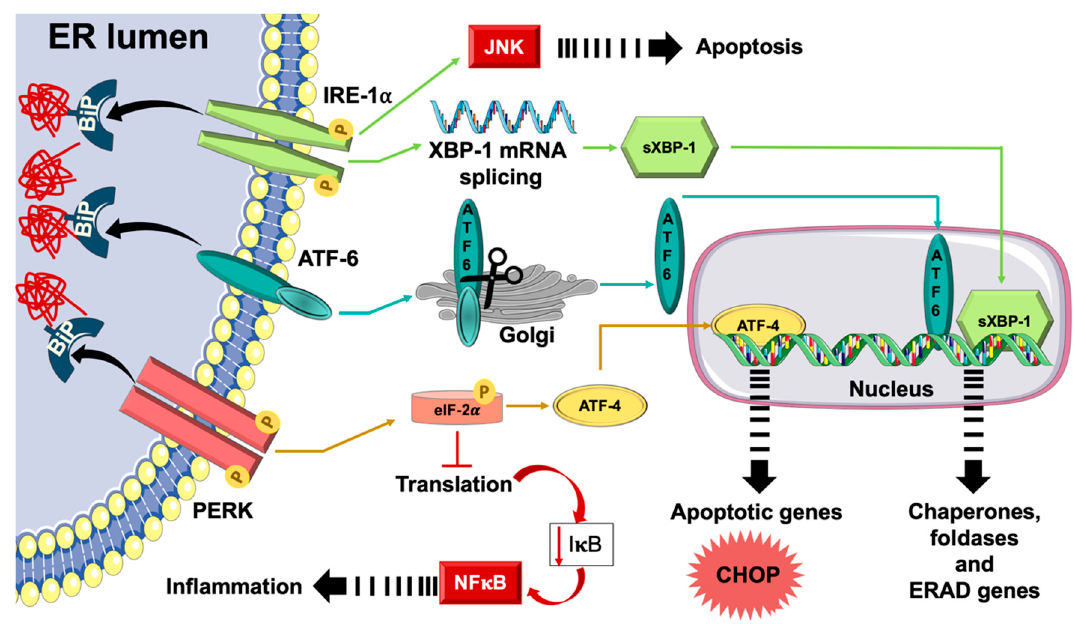
Figure 1. Unfolded protein response (UPR). Upon the buildup of misfolded and/or unfolded proteins inside the endoplasmic reticulum (ER), the chaperone, binding immunoglobulin protein (BiP), dissociates from and, thus, activating the three ER transmembrane proteins, protein kinase-like endoplasmic reticulum kinase (PERK), activating transcription factor (ATF)-6, and inositol requiring enzyme (IRE)-1 α . Activated PERK phosphorylates eukaryotic initiation factor (eIF)-2 α blunting, thus, general translation of proteins with the selective synthesis of transcription factor, ATF-4, being allowed. Free ATF-6 transfers to the Golgi apparatus where it gets cleaved and, hence, activated. Activated cleaved ATF-6 relocates to the nucleus and boosts the transcription of molecular chaperones that can help in improving ER protein folding functions. Activated IRE-1 α causes the mRNA splicing of X-box binding protein (XBP)-1 and generates an active splice variant (sXBP-1) which stimulates the transcription of genes controlling the expression of several molecular chaperones, foldases, and proteins the ER-associated degradation (ERAD) machinery aiming at restoring ER homeostasis. Prolonged activation of UPR leads to ER stress with activation of inflammatory signaling pathways, including c-Jun N-terminal Kinase (JNK) and nuclear factor (NF)- κ B, which may activate pro-inflammatory and apoptotic signals, such as CCAAT/enhancer-binding protein homologous protein (CHOP).